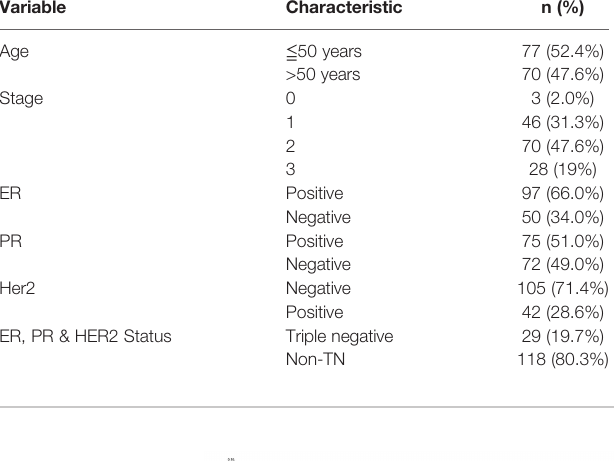
TABLE 1 | Clinical characteristics of the 147 breast cancer patients. Variable